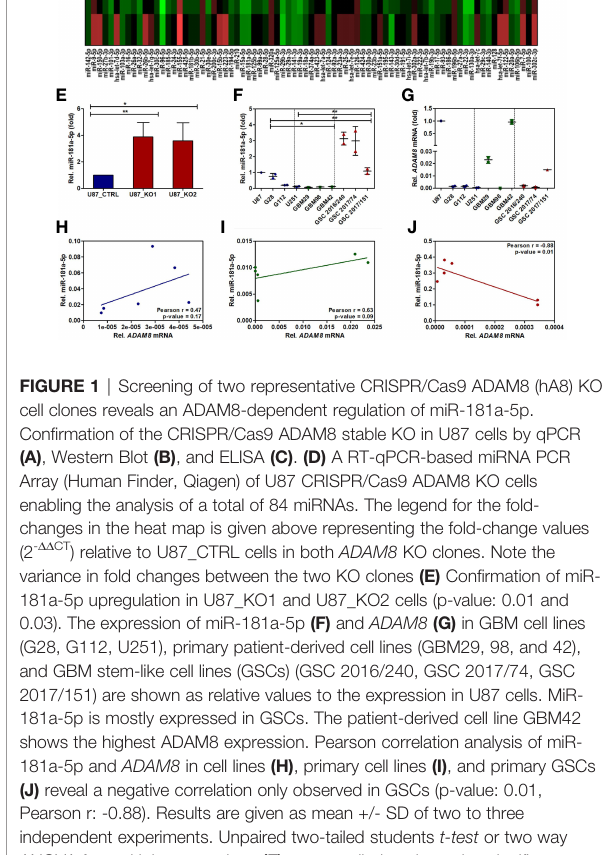
con fi rmed upregulation of miR-181a-5p in U87_KO1 and U87_KO2 compared to U87_CTRL cells, p < 0.05 and p < 0.01, respectively ( Figure 1E ).